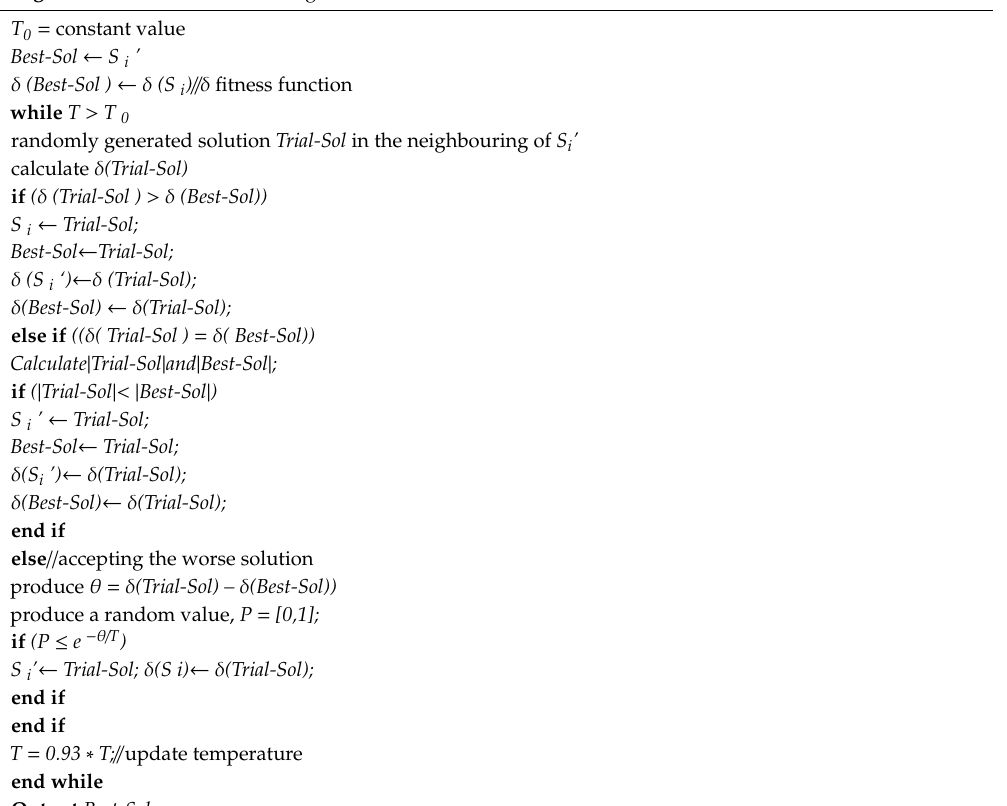
Algorithm 2 : simulated annealing local